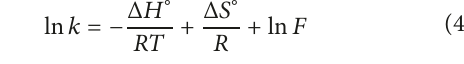
of changes in Gibbs free energy and its contributions